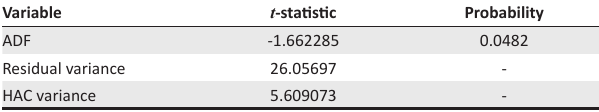
TABLE 3d: Kao panel cointegration test results.